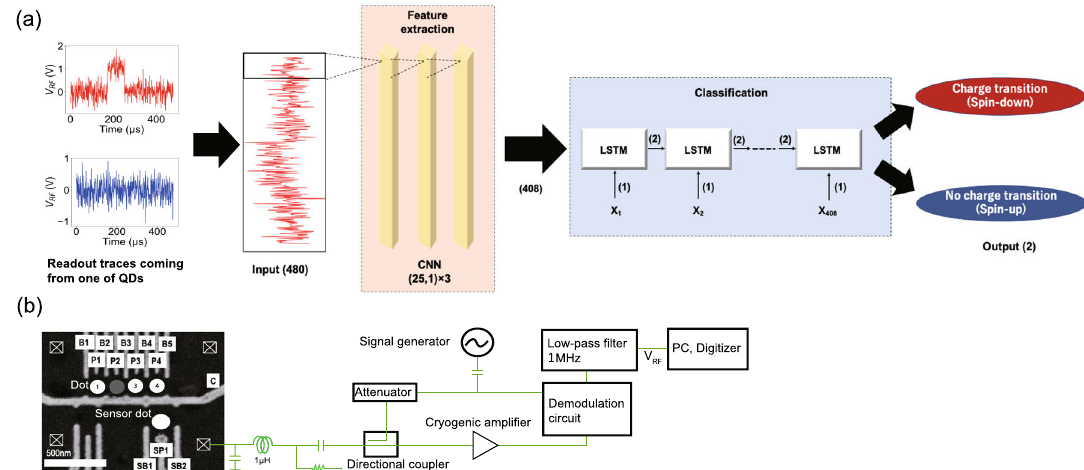
Fig. 1 The DNN architecture and the measurement setup. a Scheme of the proposed DNN classi fi cation method, where (n) indicates the number of dimensions. The red and blue traces are examples of readout traces with (red) or without a charge transition event (blue), respectively. Input for the DNN classi fi er are a 480 μ s-long data trace of the sensor response. The CNN extracts the features of charge transition events from the measured single-shot readout traces. The LSTM classi fi es the extracted features in the CNN ( X 1 ~ X 408 ) whether a charge transition is present or not. b The SEM image of a gate-de fi ned GaAs multiple QD device that is nominally identical to the one used for measurements (see methods in detail). The solid circles indicate QDs. The white squares marked with a cross show ohmic contacts. The RF re fl ectometry circuit for charge sensing was connected to one of the ohmic contacts. In all measurements, the RF signals are fi ltered by a 1 MHz low-pass fi